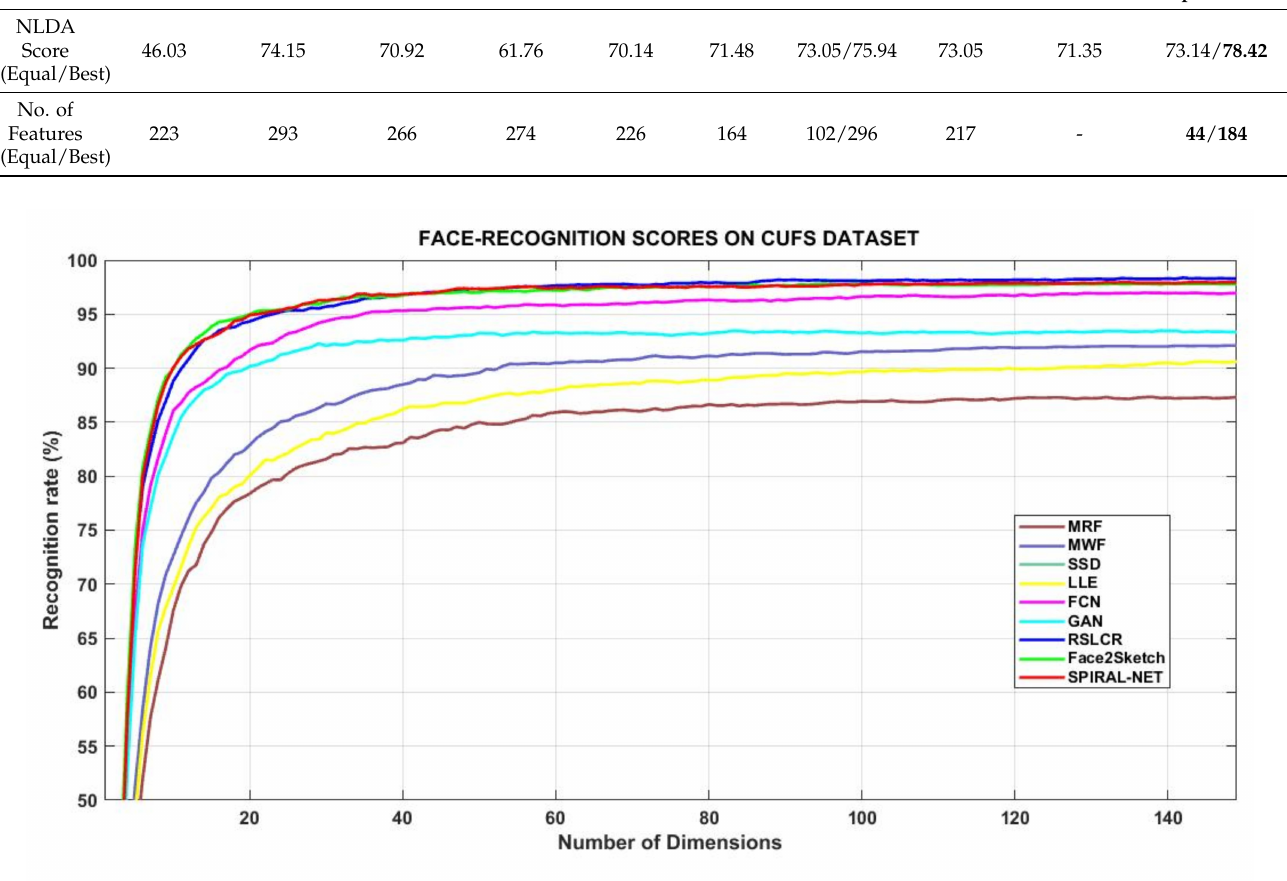
Figure 3. Comparative view of NLDA scores by different techniques on CUFS